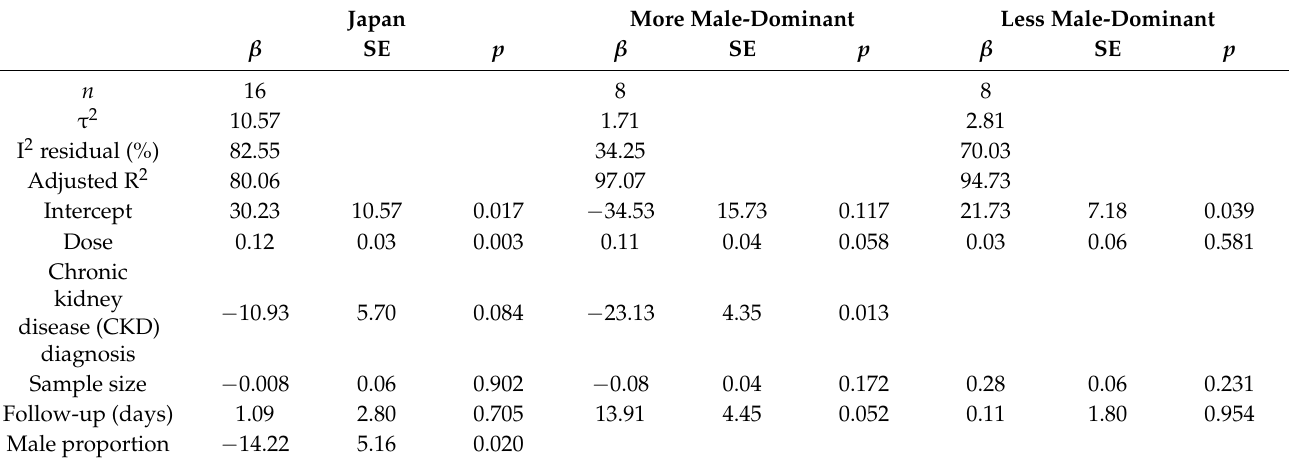
Table 4. Covariate model for topiroxostat and post-hoc analyses based on proportion of male participants [29–63]. Japan More Male-Dominant Less